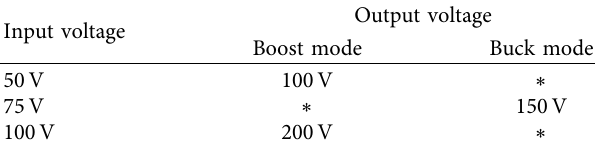
Figure 22: Output voltage waveform when V Table 5: Inferences from the voltage characteristics in